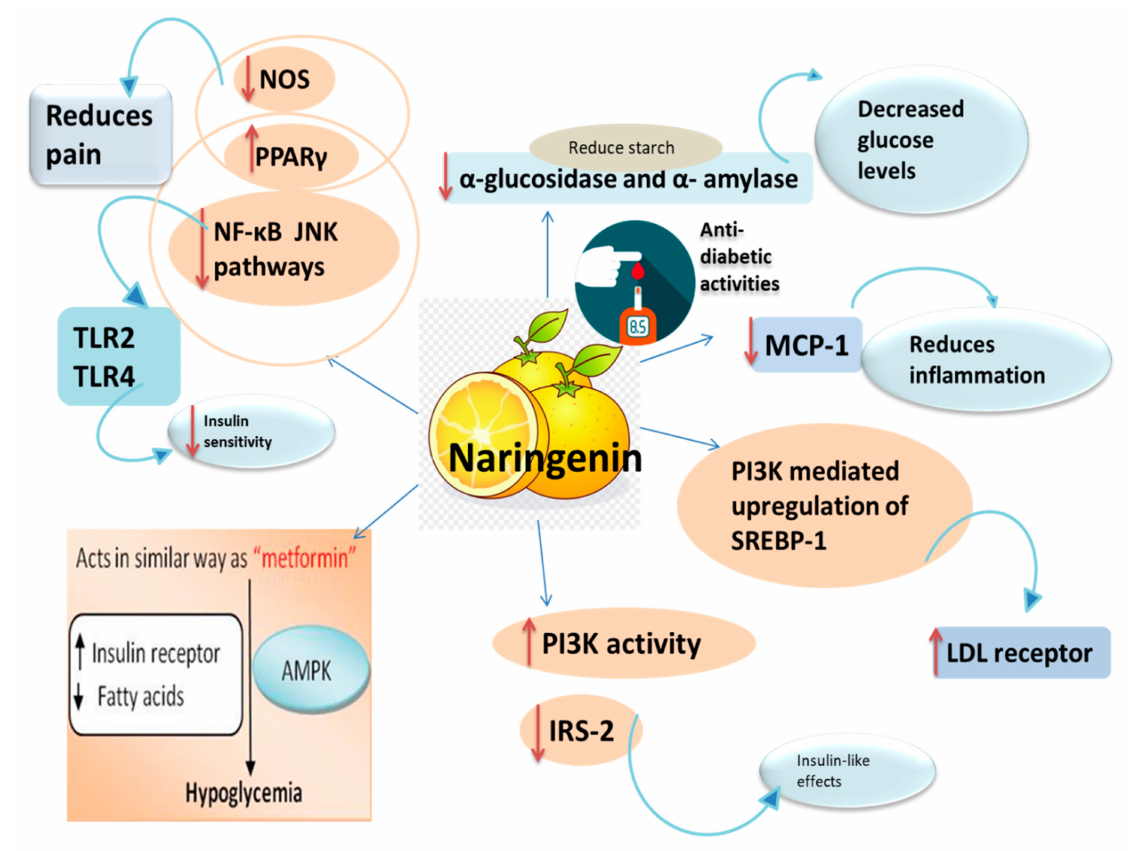
Figure 4. Di ff erent mechanisms involved in metabolic disorders such as diabetes and the role of naringenin in the regulation of several pathways involved in metabolic